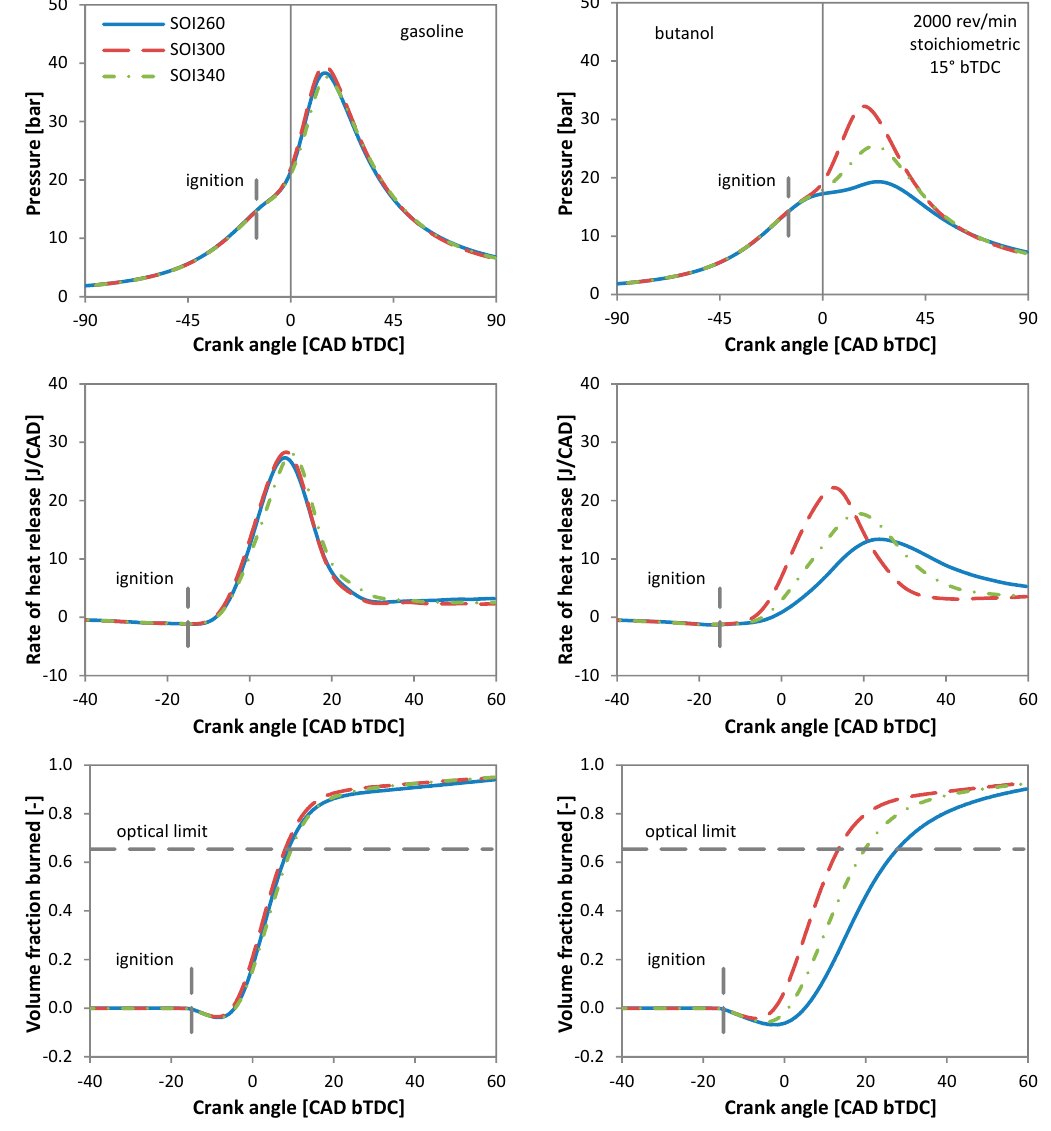
Figure 5. In-cylinder pressure and rate of heat release for: gasoline ( left ); and butanol ( right ). The volume fraction burned is also illustrated.